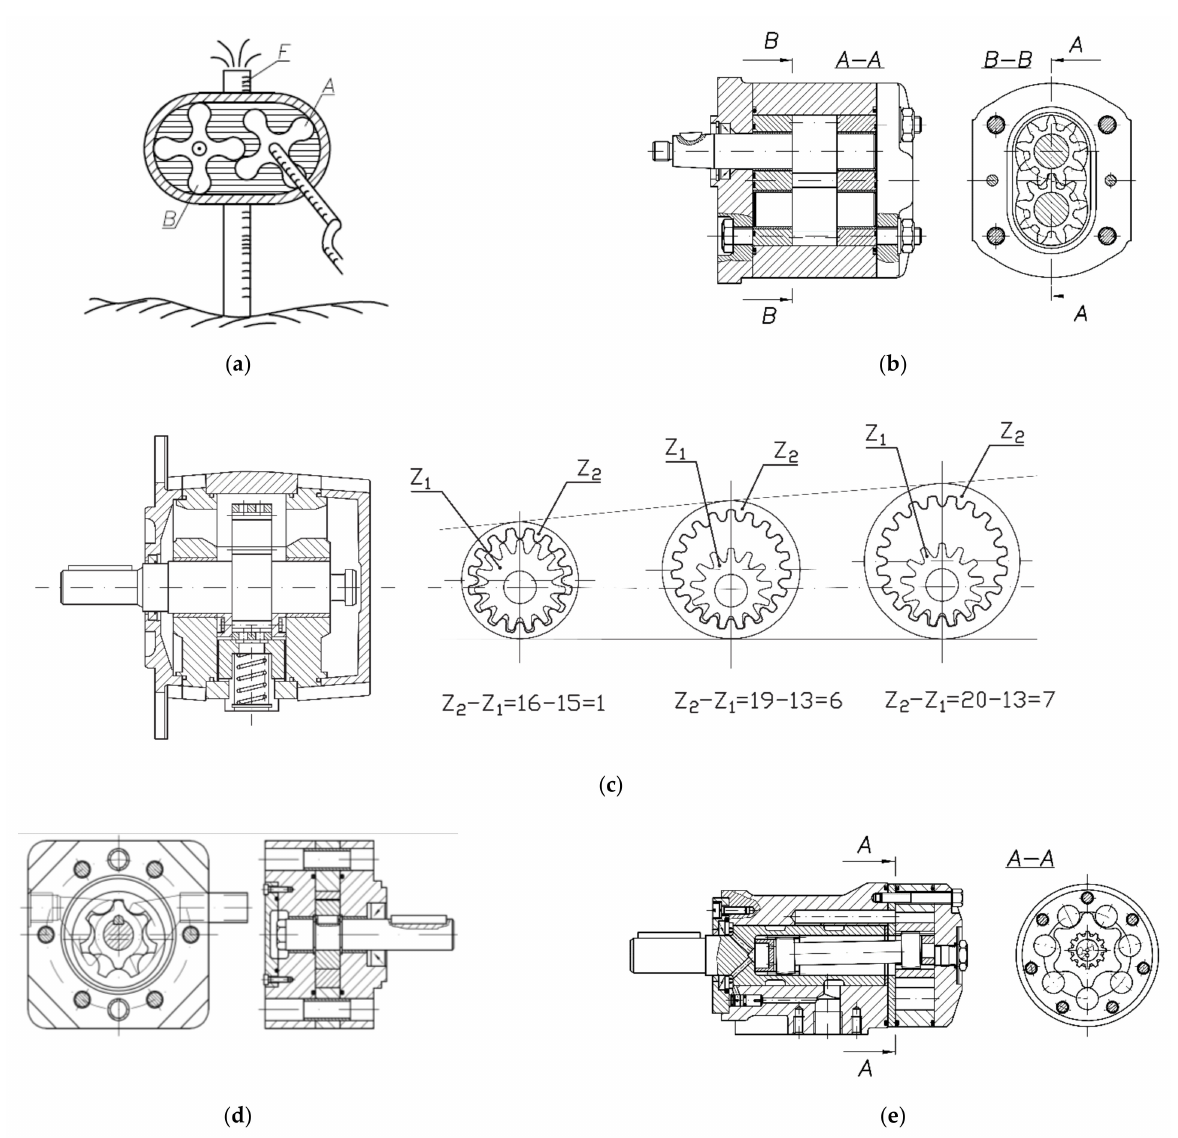
Figure 1. Overview of hydraulic gear machines: ( a ) Kepler’s gear pump; ( b ) external gear pump; ( c ) internal gear pump; ( d ) gerotor pump; ( e ) orbital